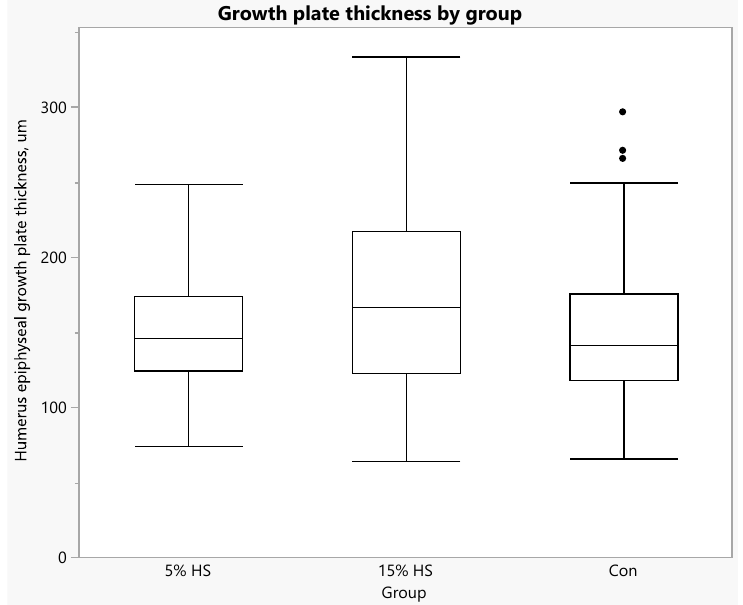
Figure 14. Box plot of thickness of the humerus epiphyseal growth plate for each diet group. Boxes depict: 75th percentile (upper edge), 50th percentile/median (middle line), 25th percentile (lower edge) and whiskers (maximum and minimum values). Main effect of group, p = 0.16. Removal of control group outliers (three dots above the 75th percentile line) resulted in a main effect of group of p = 0.06, with greater thickness in the 15% HS versus control